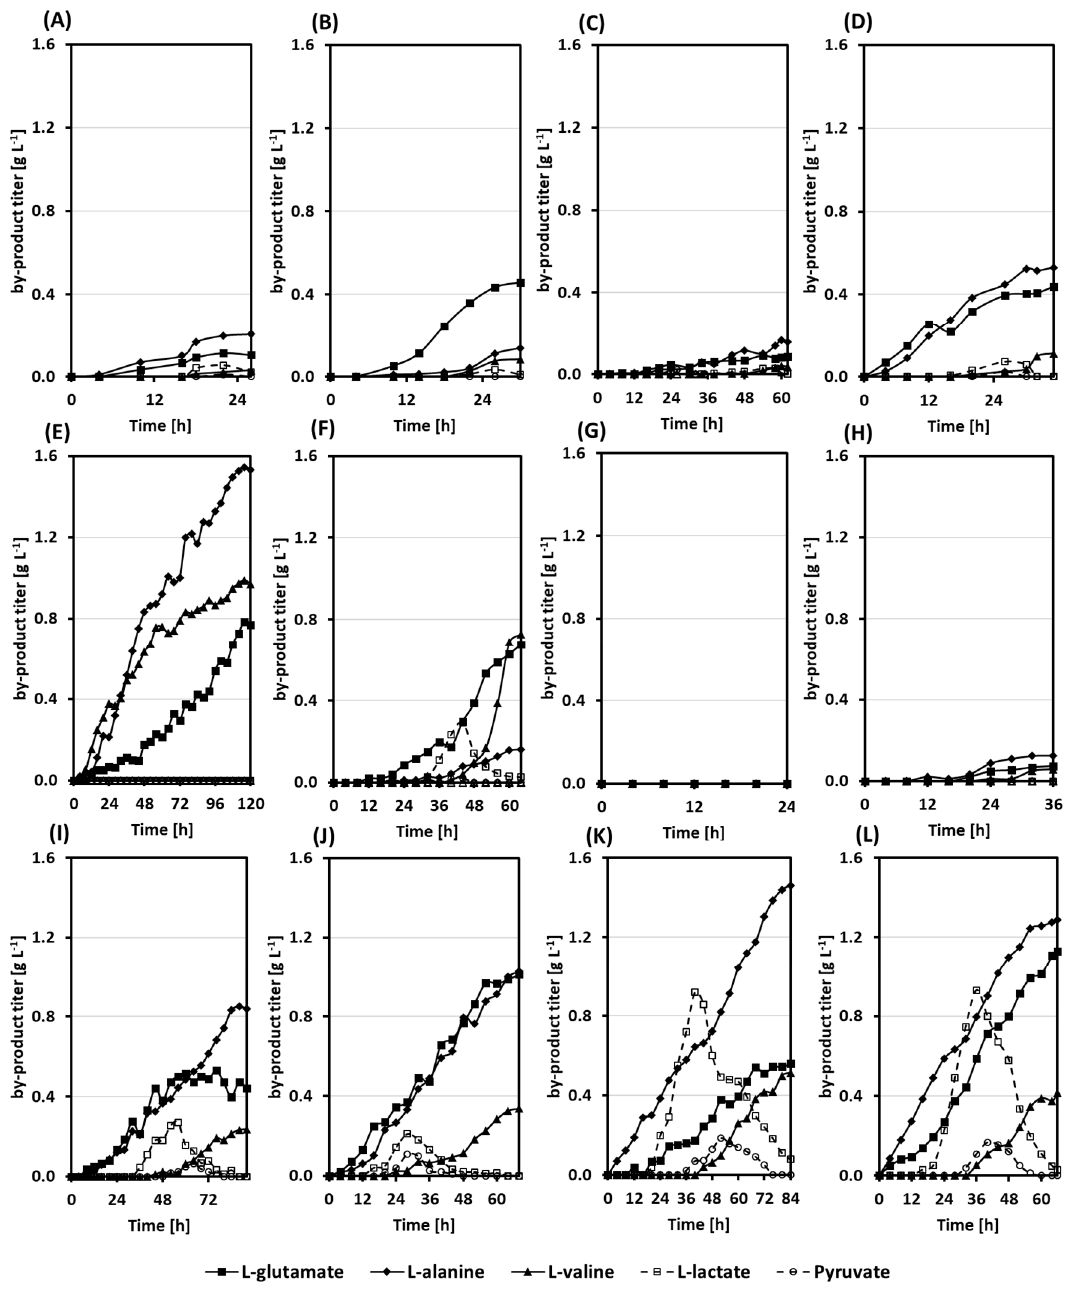
Figure 4. By-products accumulation profiles during the bioreactors bath fermentations. The combination of strain and sugar is as follows: ( A ) RiboGlu plus 20 g L − 1 of glucose; ( B ) RiboMan plus 20 g L − 1 of glucose; ( C ) RiboXyl plus 20 g L − 1 of glucose; ( D ) RiboSSL plus 20 g L − 1 of glucose; ( E ) RiboGlu plus 20 g L − 1 of mannose; ( F ) RiboMan plus 20 g L − 1 of mannose; ( G ) RiboGlu plus 20 g L − 1 of xylose; ( H ) RiboXyl plus 20 g L − 1 of xylose; ( I ) RiboGlu plus 60 g L − 1 synSSL; ( J ) RiboMan plus 60 g L − 1 synSSL; ( K ) RiboXyl plus 60 g L − 1 synSSL; ( L ) RiboSSL plus 60 g L − 1 synSSL. Data is depicted as follows: L -glutamate (filled squares), L -alanine (filled diamonds), L -alanine (filled triangles), L -lactate (empty squares), and pyruvate (empty